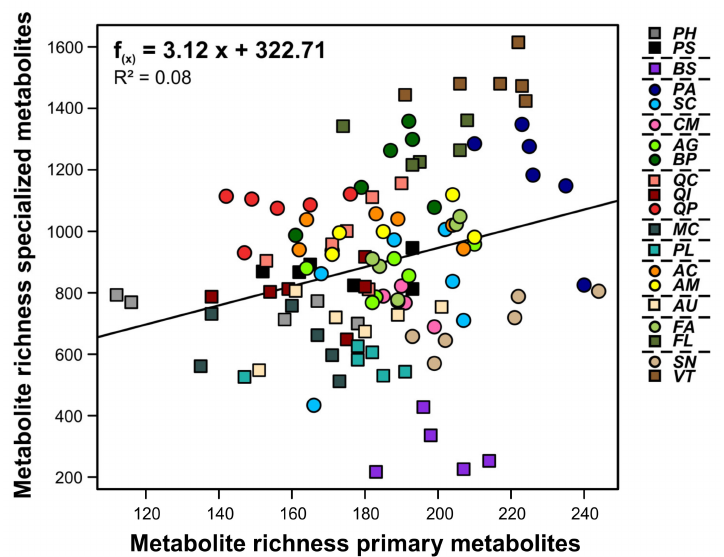
Figure 3. Relationship between numbers of metabolic features of the primary and specialized metabolism per individual detected in leaves of 20 plant species, with linear regression line. Decidu- ous species are depicted as circles and evergreen species as squares. The horizontal dashed lines in the legend separate the species by plant families. For species abbrevia-tions and taxon assignments, see Table 1.